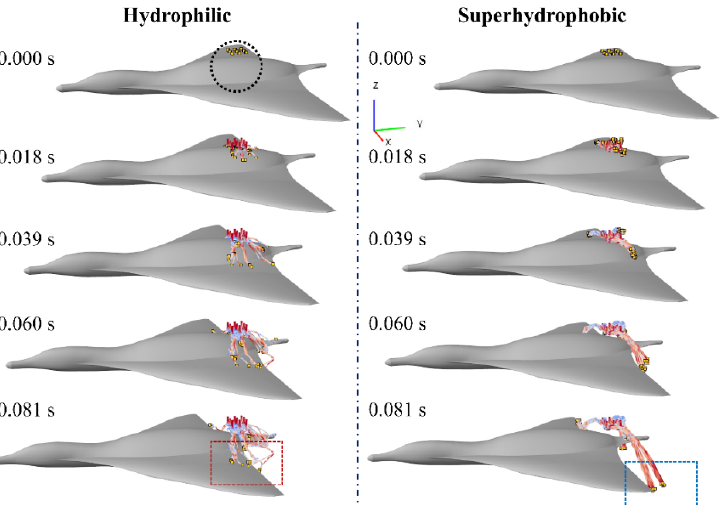
Figure 9. Comparative analysis of simulated-particle traces on hydrophilic- and superhydrophobic- model surfaces. For hydrophilic surfaces, the traces are staggered, which indicates that the attached water bodies create pinning on the surface (see the selected square area on the left), the adhering water already exists on the surface, and it is difficult to detach. However, regular traces were observed on the superhydrophobic surface, which implies regular directional bouncing during the desorption process (see the selected square area on the right). Directional flow, induced by both motion and “Supporting Movie S7” in the Supplementary Material).